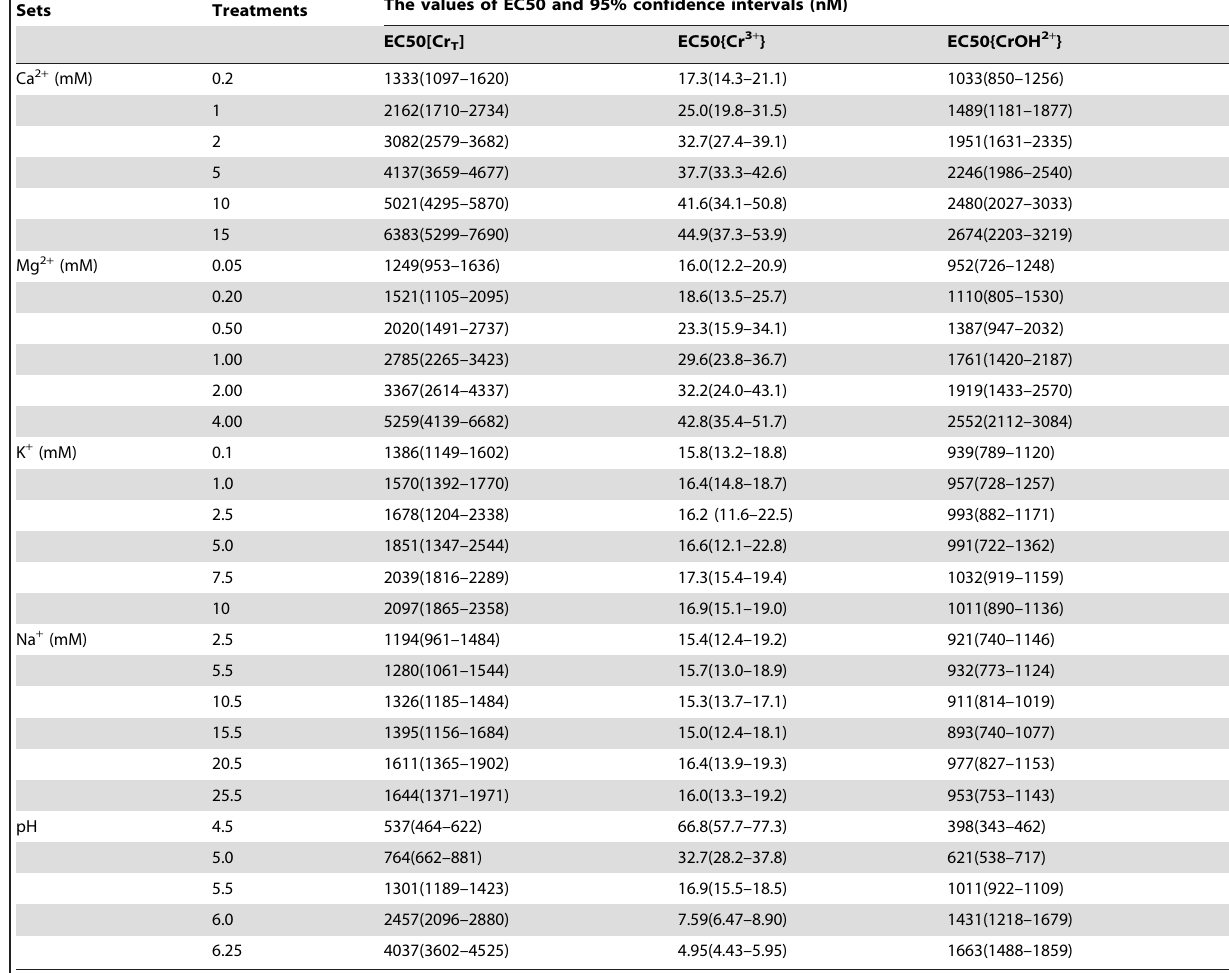
Table 1. Chemical composition of the solution cultures used in the different sets and the measured Cr toxicity threshold at 50% inhibition expressed by total concentration of Cr(III) ( EC50[Cr T ]), free Cr activity (EC50{Cr 3 + }) and CrOH 2 + activity (EC50{CrOH 2 + }) for barely root elongation with 95% confidence intervals.